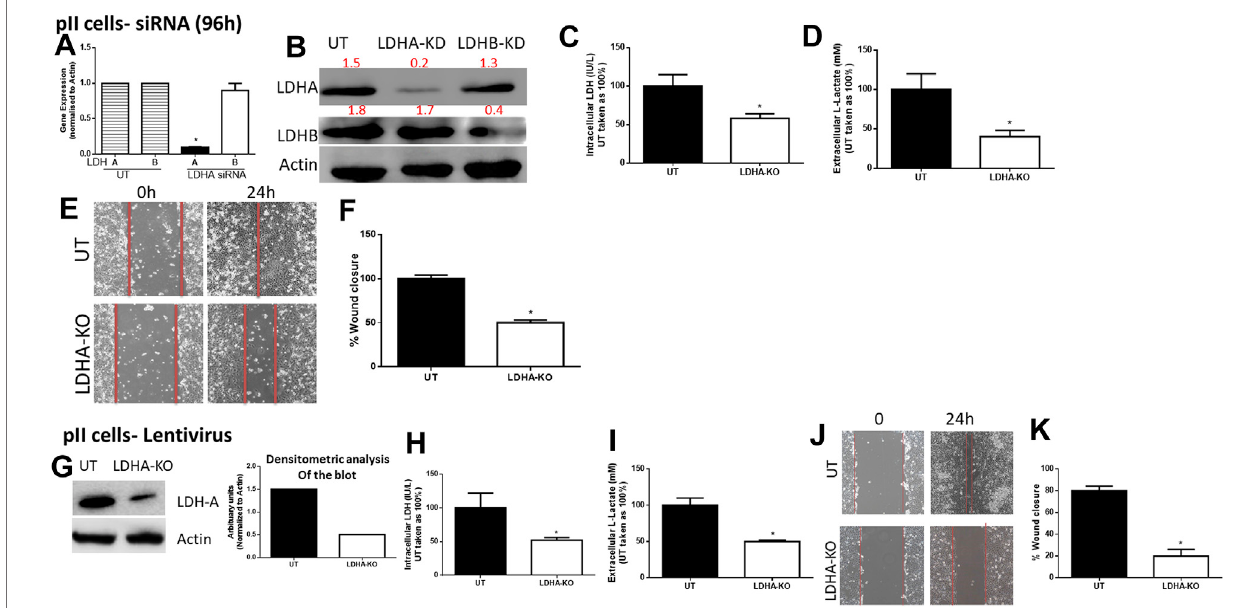
FIGURE 3| Effect of LDH-A knockdown in the ER − ve breast cancer cell pII, (A) show LDH-A and LDH-B (normalized to actin) mRNA expression pro fi le.* p < 0.05 Vs. UT cells ( n (cid:2) 3 per group). (B) show western blotting analysis of LDH-A and actin (loading control) in untreated (UT), or cells treated with LDH-A or LDH-B siRNA for 96 h. Densitometric analysis of the blot is also included. The blot represents one out of three similar experiments. (C,D) show LDH activity and lactate level respectively. * p < 0.05 Vs. UT cells ( n (cid:2) 3 per group). (E,F) show the percentage of wound closure (using scratch assay). * p < 0.05 Vs. UT cells ( n (cid:2) 6 per group). (G) show western blotting analysis of LDH-A and actin (loading control) in untreated (UT), or cells treated with LDH-A lentivirus. Densitometric analysis of the blot is also included. Theblotrepresentsoneoutofthreesimilarexperiments. (H,I) showLDHactivityandlactatelevelrespectively.* p < 0.05Vs.UTcells( n (cid:2) 3pergroup).Panels (J,K) show the percentage of wound closure (using scratch assay). * p < 0.05 Vs. UT cells ( n (cid:2) 6 per group).